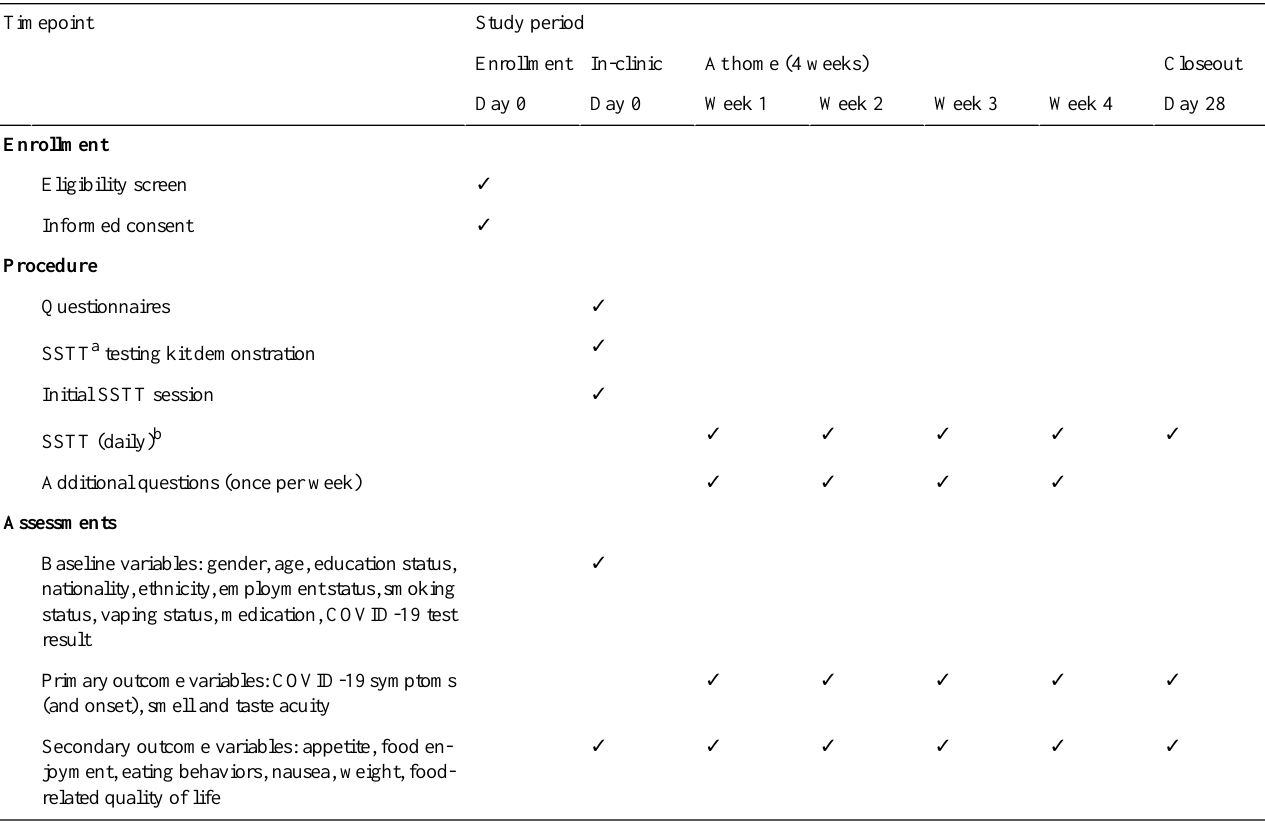
Table 1. Schedule of participant enrolment, intervention, and assessment in the COVOSMIA-19 trial. Study